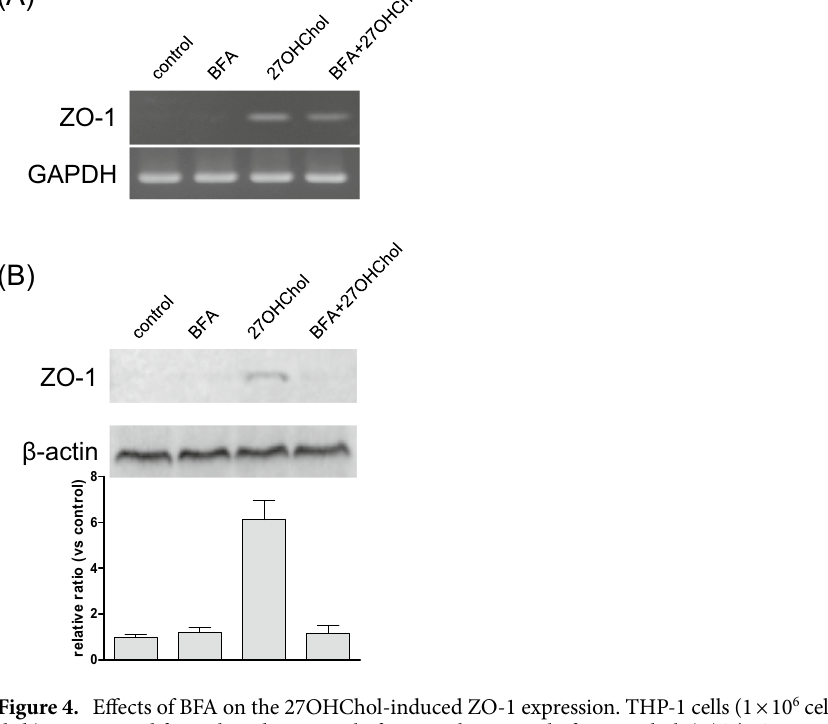
Figure 4. Effects of BFA on the 27OHChol-induced ZO-1 expression. THP-1 cells (1 × 10 6 cells/60-mm culture dish) were treated for 48 h with 10 µg/ml of BFA and 2.5 µg/ml of 27OHChol. ( A ) The ZO-1 transcript levels were analyzed using RT-PCR. ( B ) The expressed protein of ZO-1 on cell surface was harvested with Cell